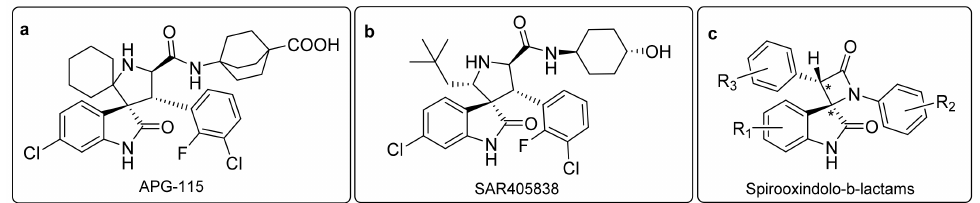
Figure 1. Spirooxindole-based small-molecule inhibitors of MDM2. Spirooxindole-pyrrolidines: ( a ) APG-115, ( b ) SAR405838; ( c ) bis-aryl spirooxindole- β